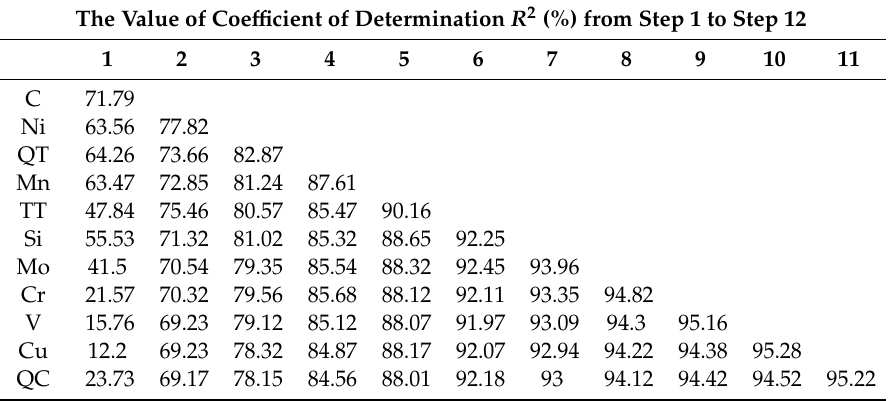
Table 2. Results of FS of parameters that impact the tensile strength. The Value of Coefficient of Determination R 2 (%) from Step 1 to Step 12